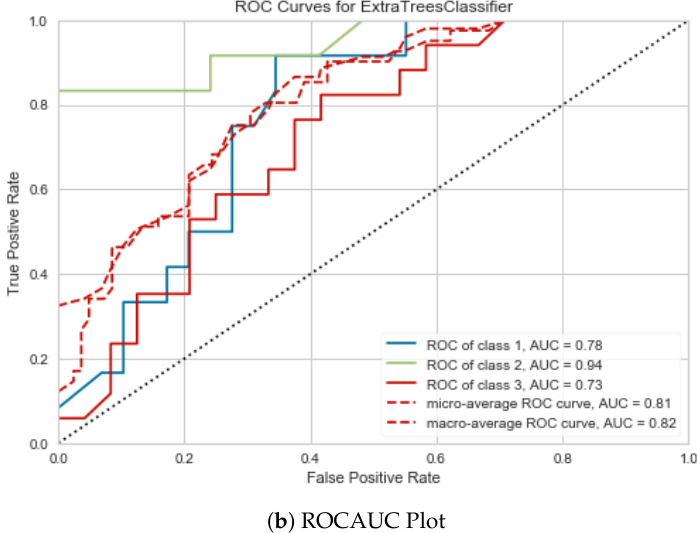
Figure 12. Performance of ET on Haiti.